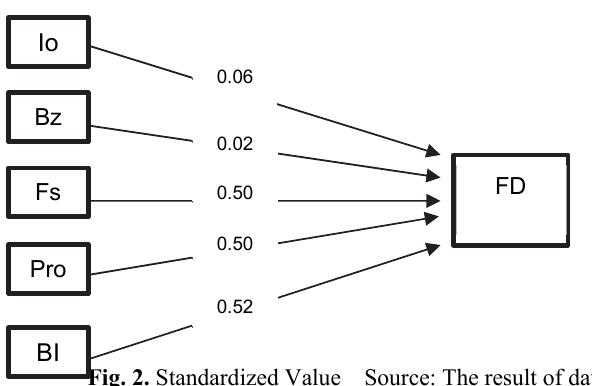
Fig. 2. Standardized Value Source: The result of data processing by